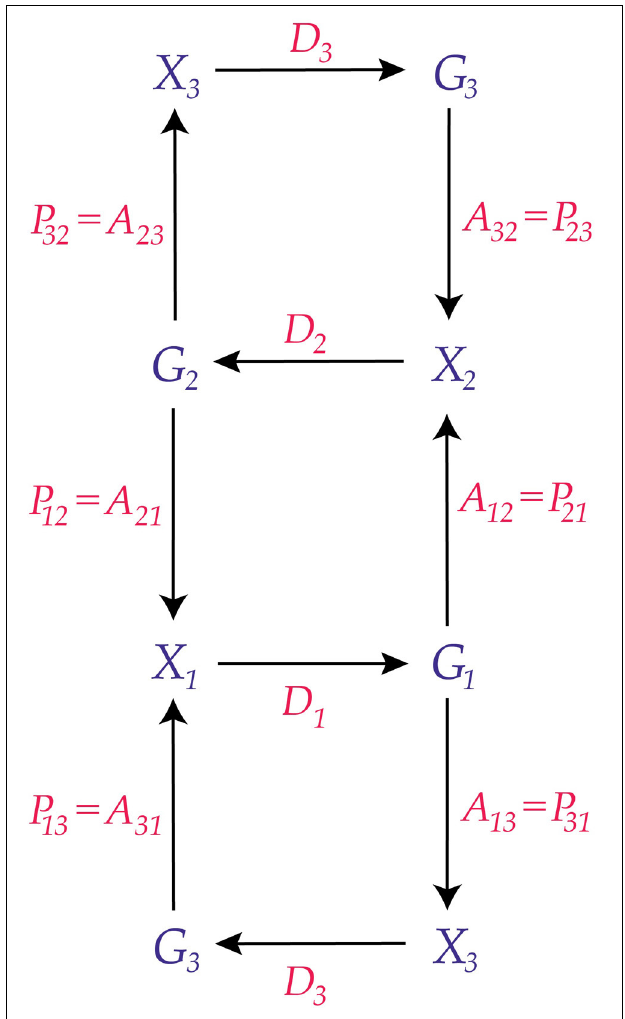
FIGURE 4 | Three adjacent conscious agents. The third agent is replicated at the top and bottom of the diagram for visual simplicity.